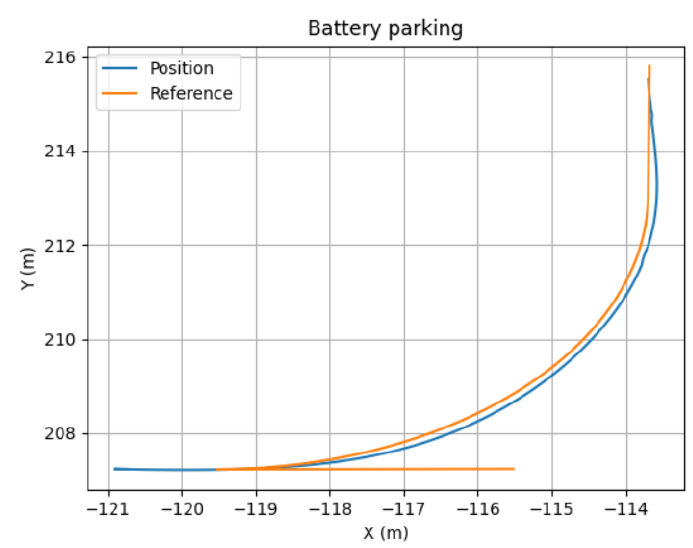
Figure 21. Position and reference in the battery parking